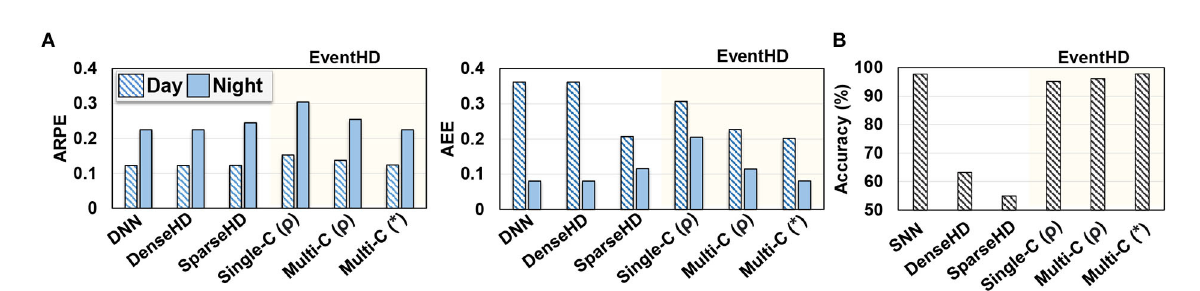
FIGURE5 EventHD quality of learning over MVSEC and N-MNIST datasets (A,B) . The results are compared to the state-of-the-art HDC-based approach. For DNN, SNN, SparseHD, and DenseHD, we use their original implementation and allow preprocessing as needed. For EventHD , we report the results for single-class (Single-C) and multi-class (Mult-C) updates. For multi-class, we also report results for permutation-based temporal encoding ( ρ ) and association-based temporal encoding ( ∗ ). Evaluations for MVSEC are measured by Average Relative Pose Error (ARPE) and Average End-point Error (AEE), and that for N-MNIST is classification. accuracy. EventHD provides comparable or better quality of learning compared to state-of-the-art